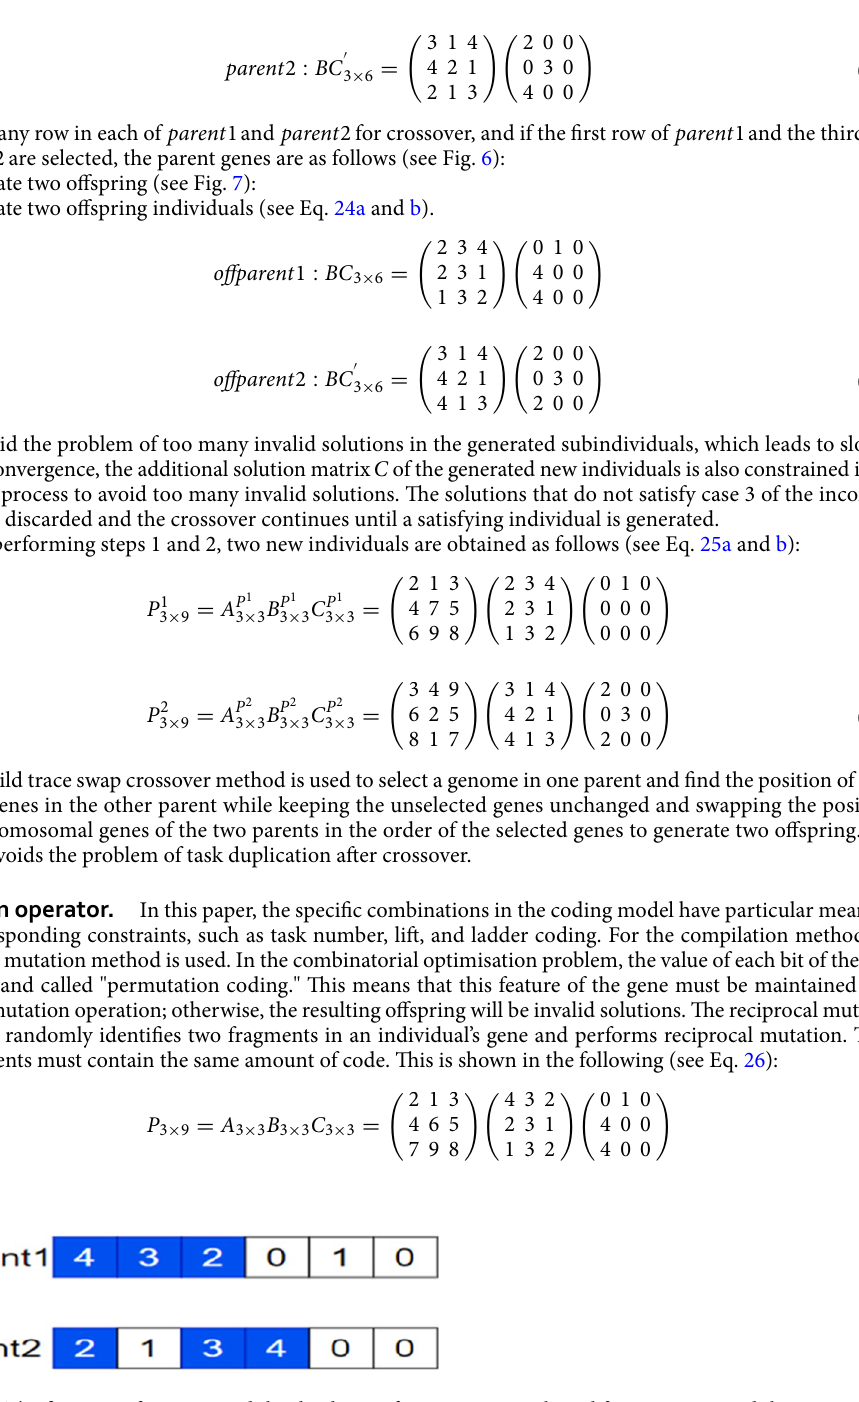
Figure 6. The first row of parent 1 and the third row of parent 2 were selected for crossover, and the parental gene map at this point.